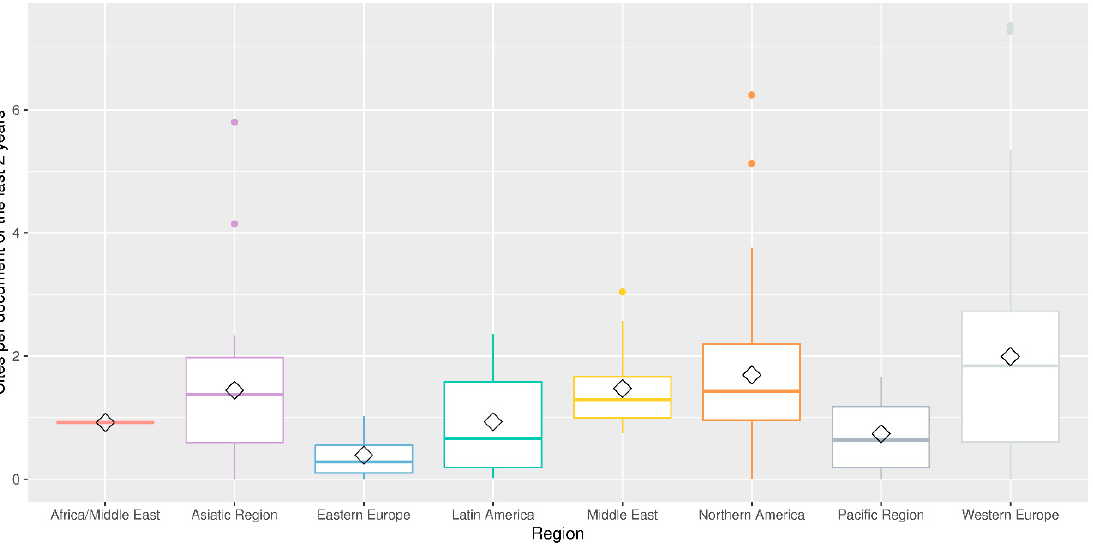
Figure 9. Global comparison of citations per document between all regions.